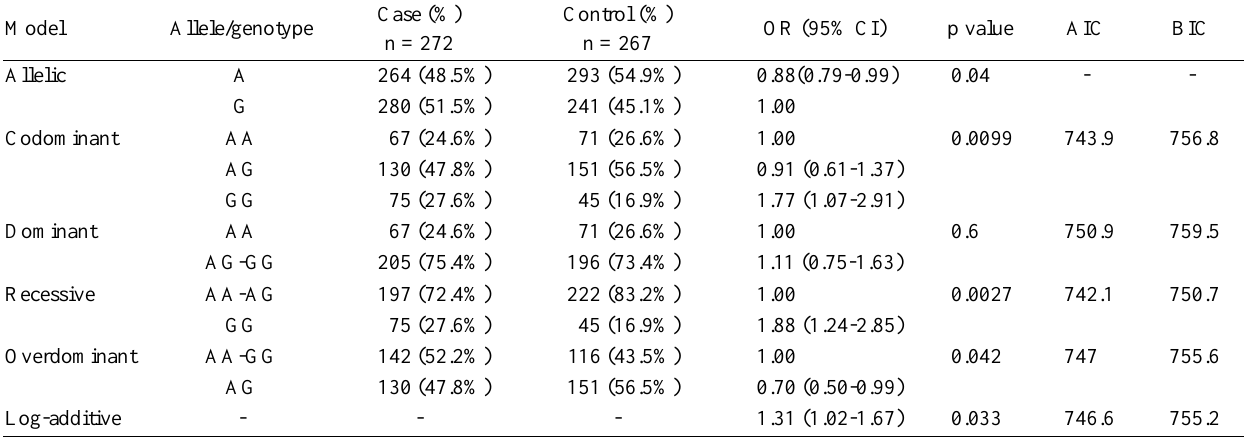
Table 4. NLRP12 c.1682A>G allele and genotype association with digestive disorder in rabbits